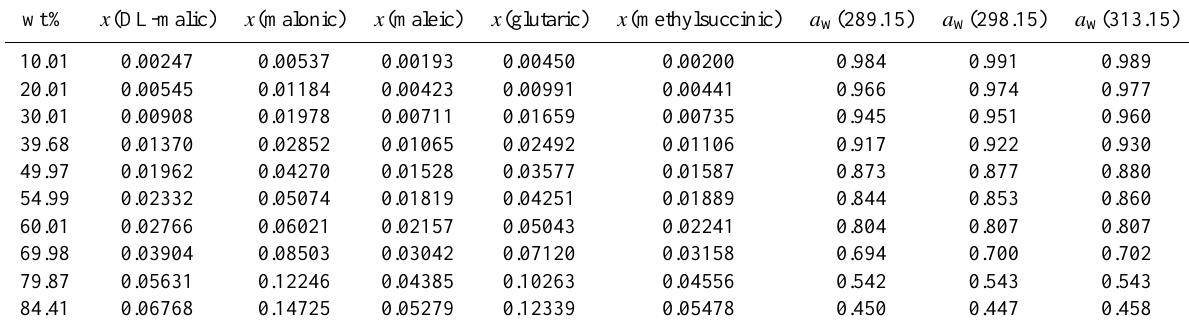
Table 7. Bulk water activity (a w ) measurements ∗ of aqueous M5 solutions at 289.15, 298.15 and 313.15K. The total organic mass fraction of the solution is given in the first column in wt% and the composition in terms of individual components is given in mole fractions of the dicarboxylic acids constituting the M5 mixture.